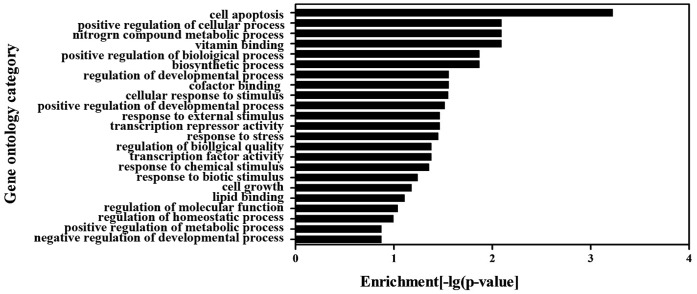
The GO category for the up-regulated genes in clopidogrel group.A P value <0.05 was used as a cut-off threshold to select significant GO categories. The higher the enrichment, the more significant the biological processes.